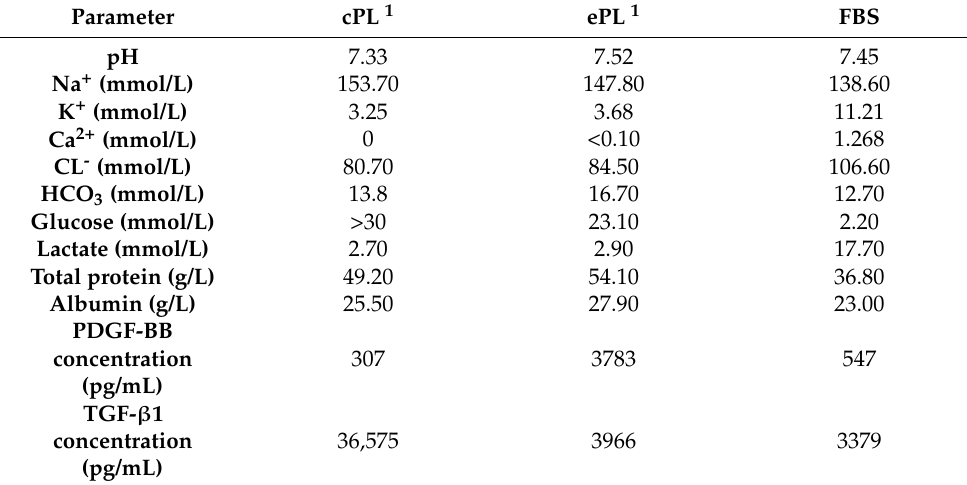
Table 2. Chemical analysis of the cell culture